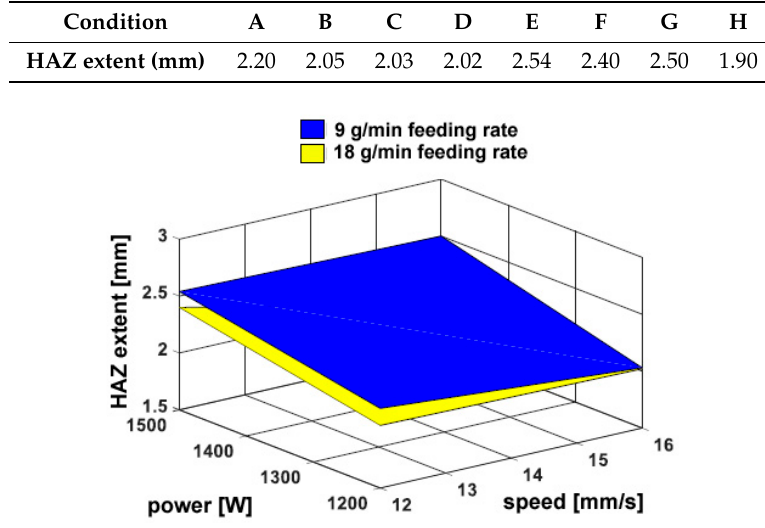
Figure 11. Extent of the HAZ as a function of the processing conditions; flat deposition.